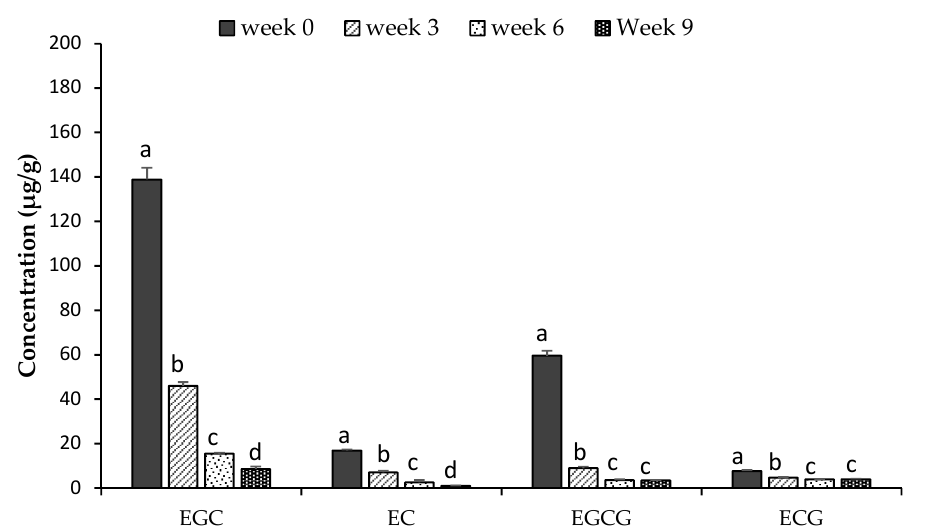
Figure 2. Catechins in DHA-rich oil supplemented with green tea extract at 1000 ppm and stored over 9 weeks at 30 °C. Values are presented as mean ± SD (n = 3). Different letters (a–d) for each catechin indicate a significant difference ( p ≤ 0.05) during storage. EGC = epigallocatechin, EC = epicatechin, EGCG = epigallocatechin gallate, ECG = epicatechin gallate.